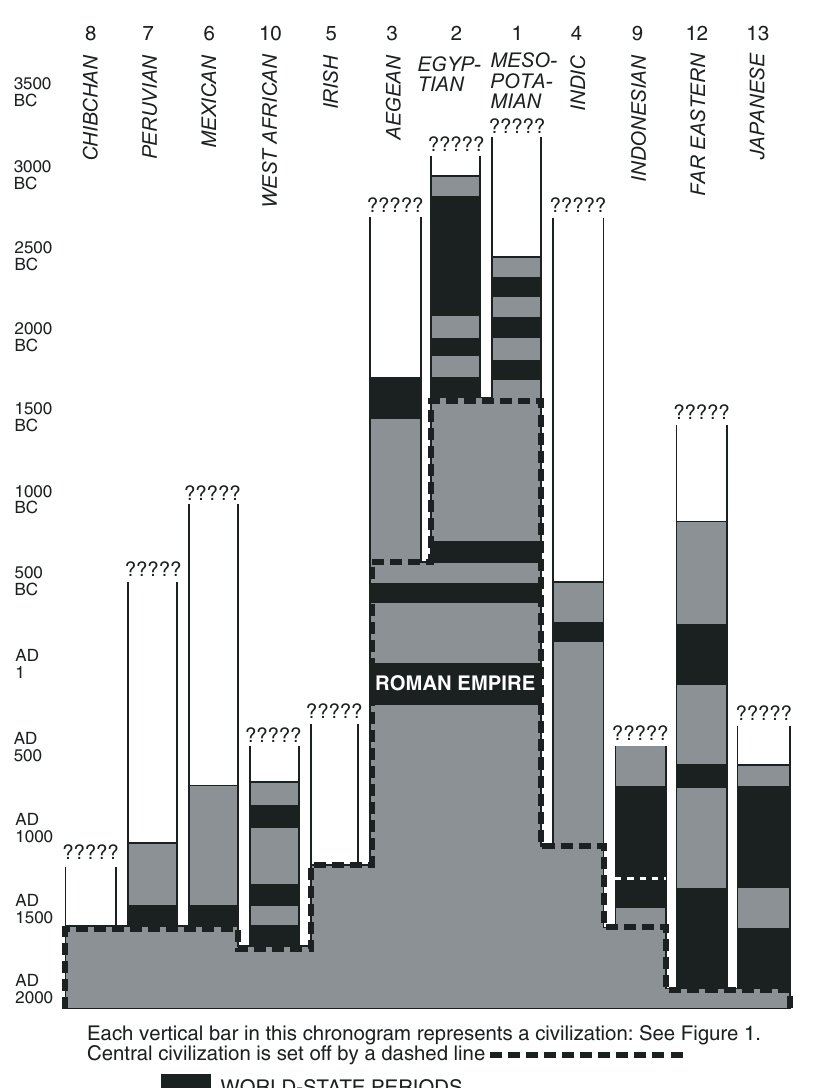
Each vertical bar in this chronogram represents a civilization: See Figure 1. Central civilization is set off by a